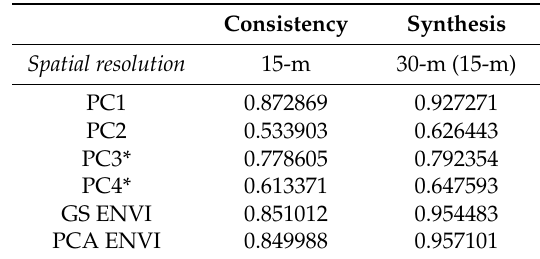
Table 9. QNR for the Landsat 8 dataset. Values of the QNR vary between 0 and 1, the closer to 1 the result is, the more similar to the original image the fused image is. It was expected that the first two PCs have the potential to give good results when employing the PCA sharpening process, however PC3* and PC4* were used to compare the result and explain it in a wider context.